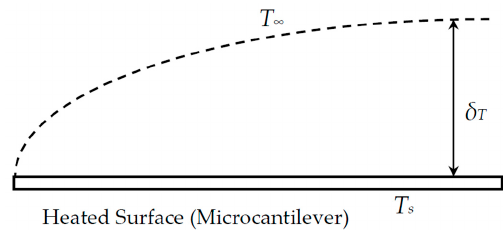
Figure 8. Schematic representation for thermal boundary layer on natural convection over a horizontal plate.